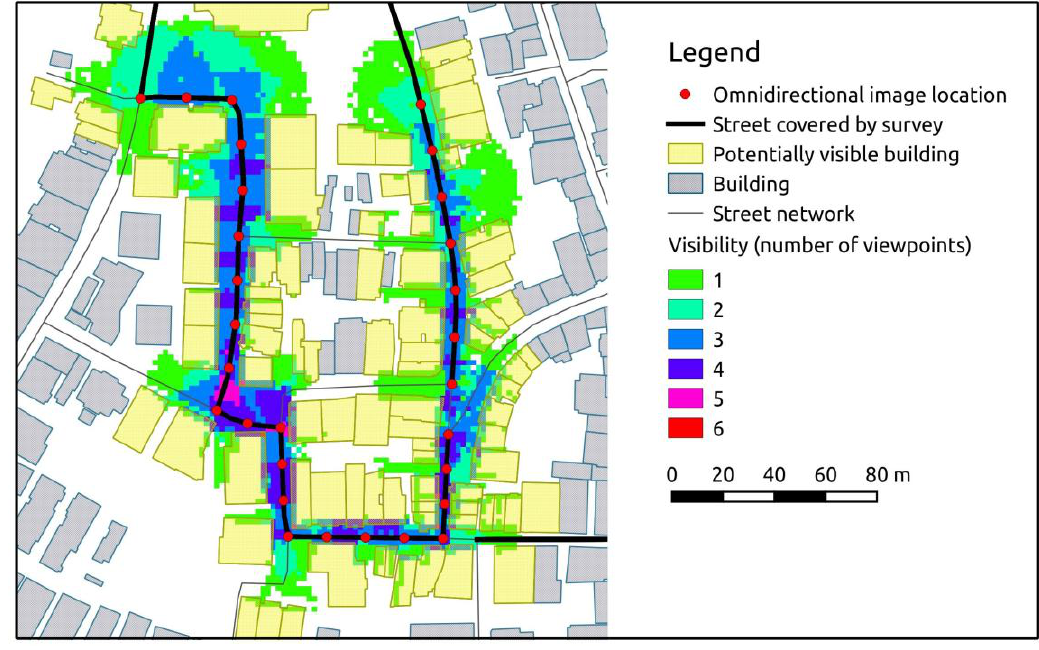
Figure 11. Visibility analysis based on viewshed estimation for a subset of the buildings theoretically imaged by the mobile mapping